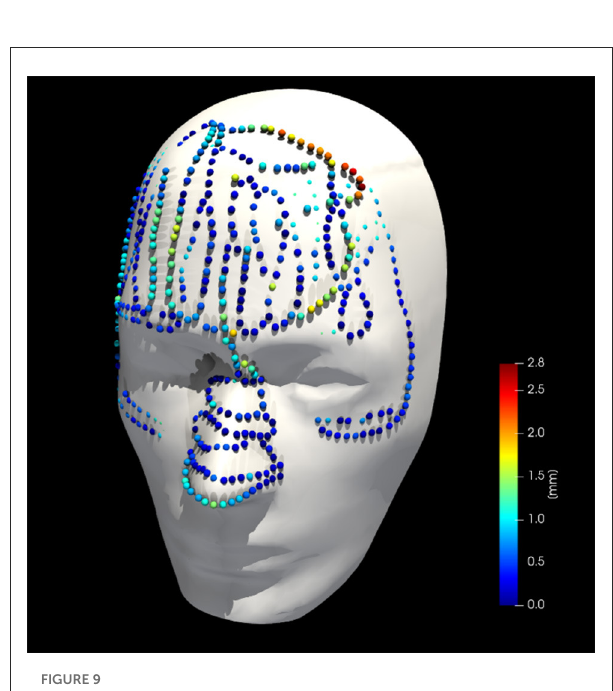
FIGURE9 Collected point cloud data and registered phantom for a single case; point colors are scaled to point-to-surface distance.